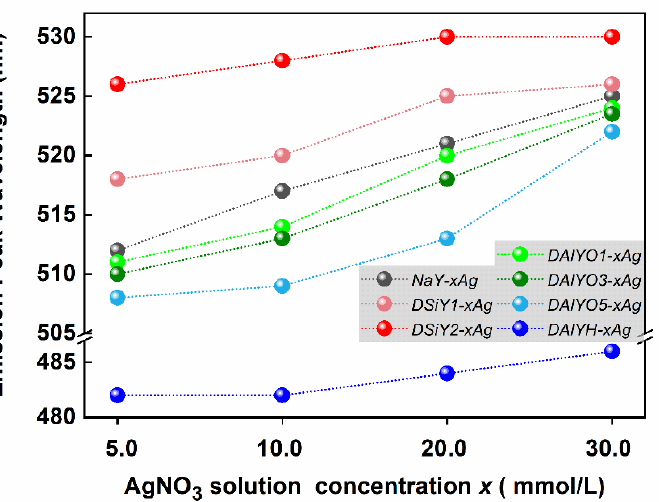
Figure 7. Summary of Ag CLs emission peak wavelength in FAUY and desilicated and dealuminated FAUY zeolite with increasing Ag + -exchanged amount.